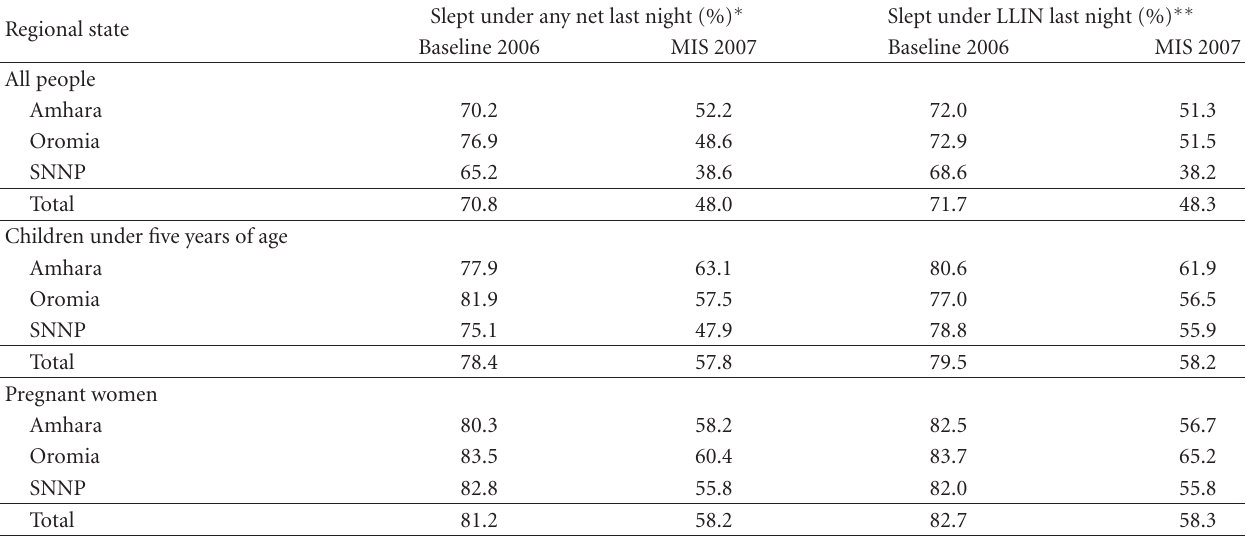
Table 3: Proportion of people who reported sleeping under a net in households that owned at least one net in malarious areas of three regional states.